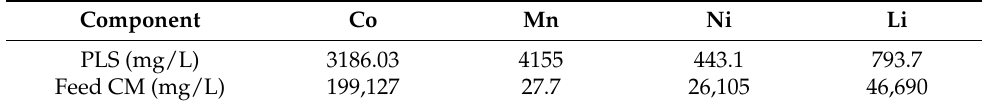
Table 1. Elemental compositions of prepared and filtered PLS.